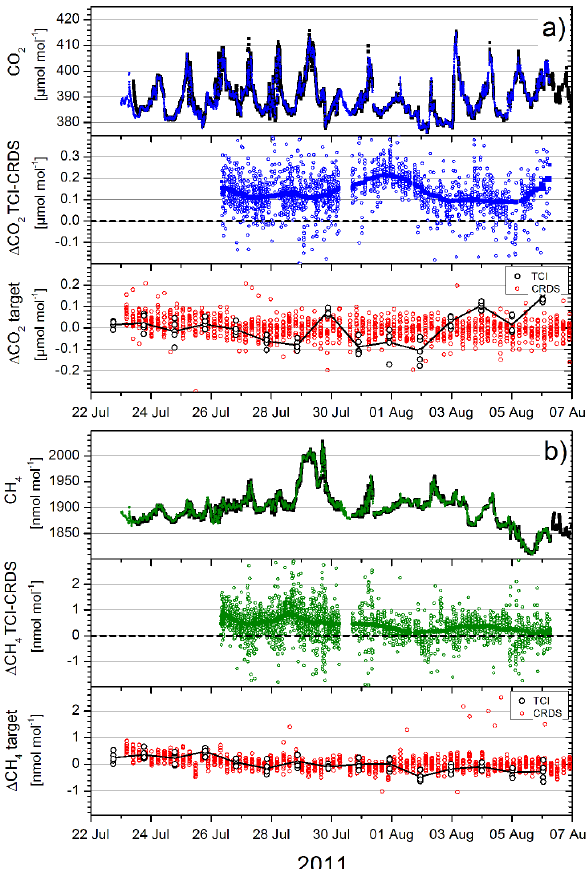
Fig. 3. Upper panels in (a) and (b) : comparison of CRDS (black) and TCI (blue/green) of CO 2 or CH 4 measurements performed at the 200m level at CBW. Middle panels: individual 3min mean CO 2 or CH 4 differences between the TCI and the smoothed CRDS measurements (open symbols); averaged differences (4h running median filter) as filled symbols. Lower panels: individual 1min CRDS target measurements in red and individual 3min TCI target measurements in black. For both instruments the target/surveillance gas deviations are given in a way to allow for direct trend comparison to the ambient air differences.